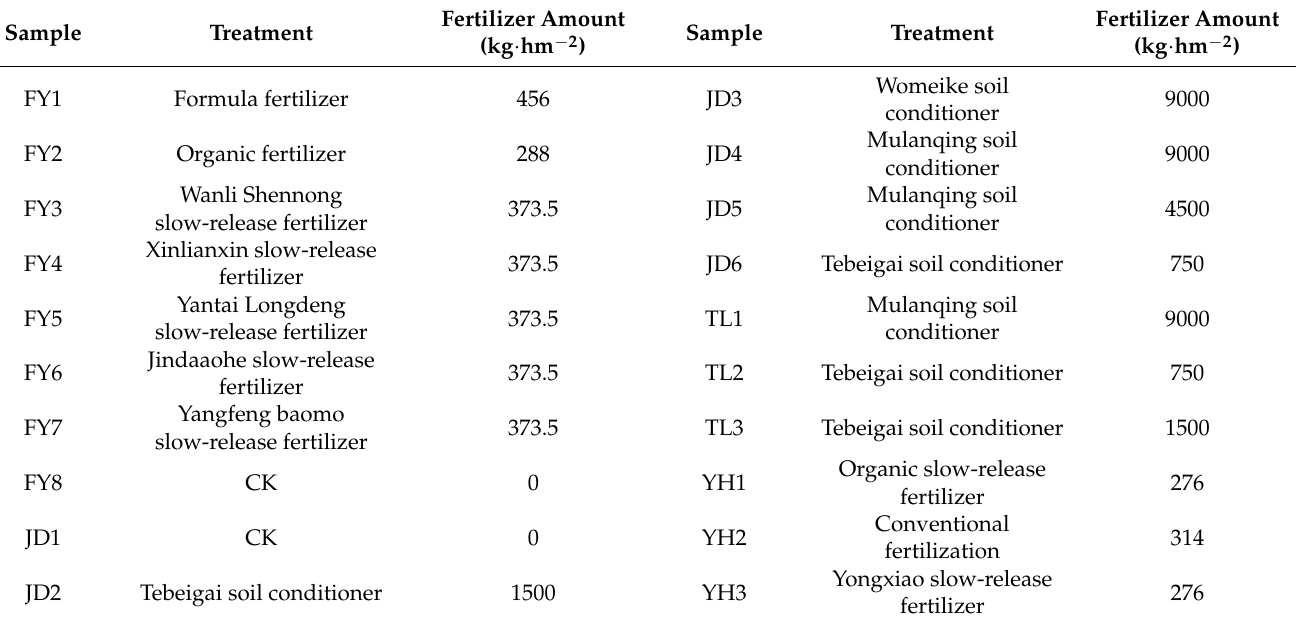
Table 1. The fertilization treatment and fertilizer amount of soil samples from Fuyang and Yuhang districts, and from Jiande and Tonglu